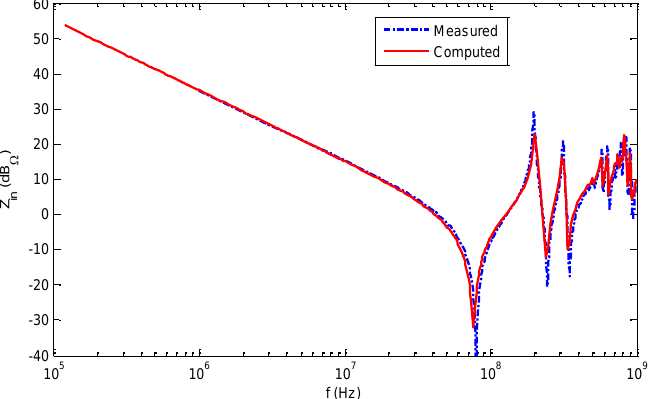
Figure 15. Comparison between the measured and computed values of the input impedance at the port P of the PDN board in Figure 14 without decaps.